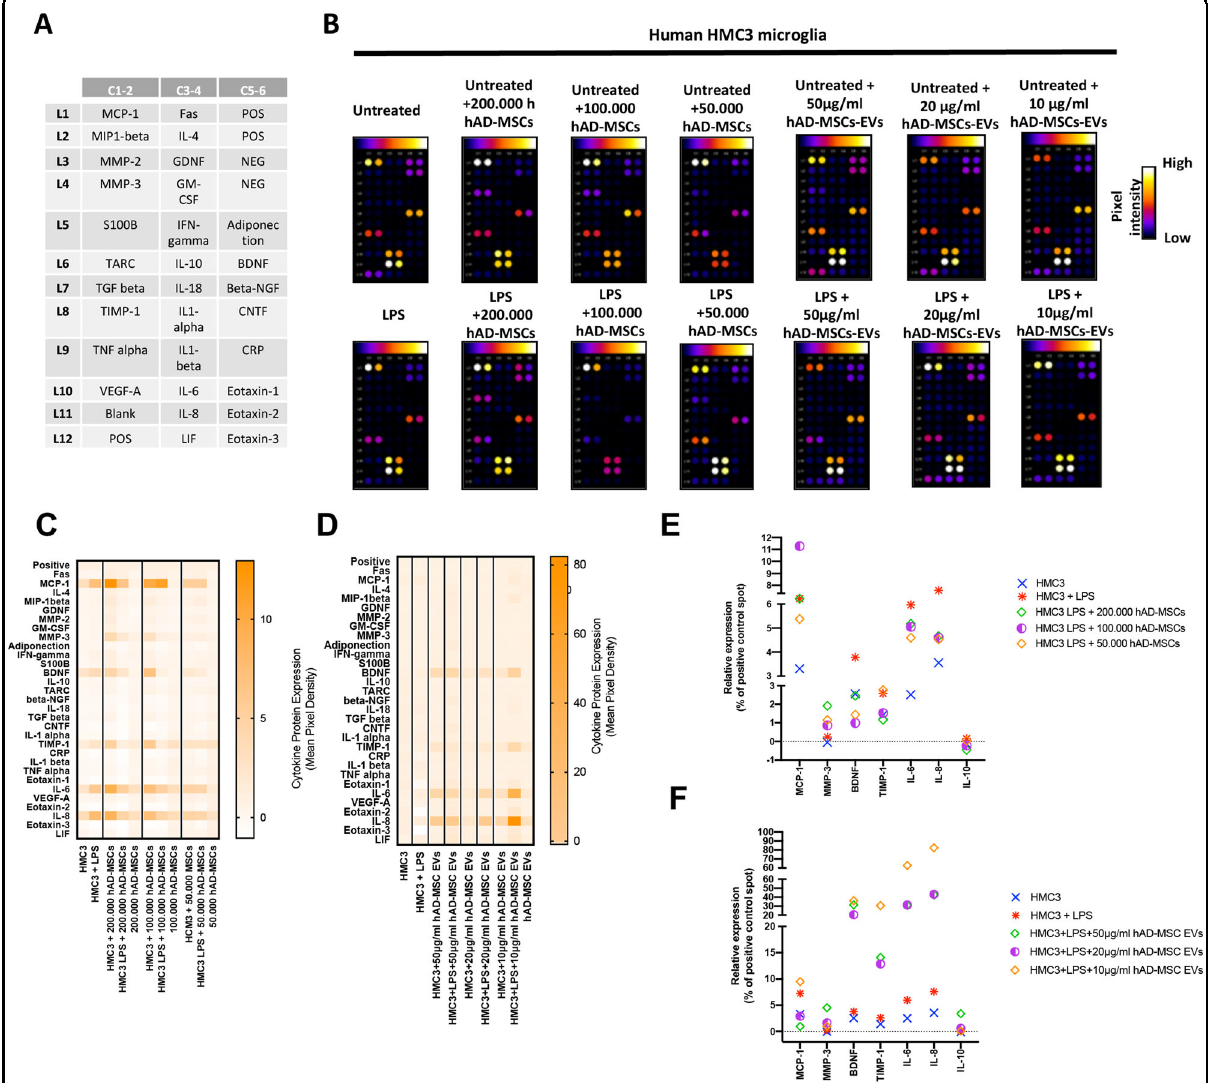
Fig. 6 Changes on cytokine production in untreated or LPS-stimulated HMC3 microglia mediated by human adipose tissue-mesenchymal stem cells and extracellular vesicles. A Gene map of cytokine array; all spots are in duplicate. B Image of coculture cytokine arrays, and human adipose tissue-derived stem cells or extracellular vesicles. C , D Heat map showing relative cytokines expression. E , F Representation of cytokines relative expression. The values are shown as the relative mean pixel